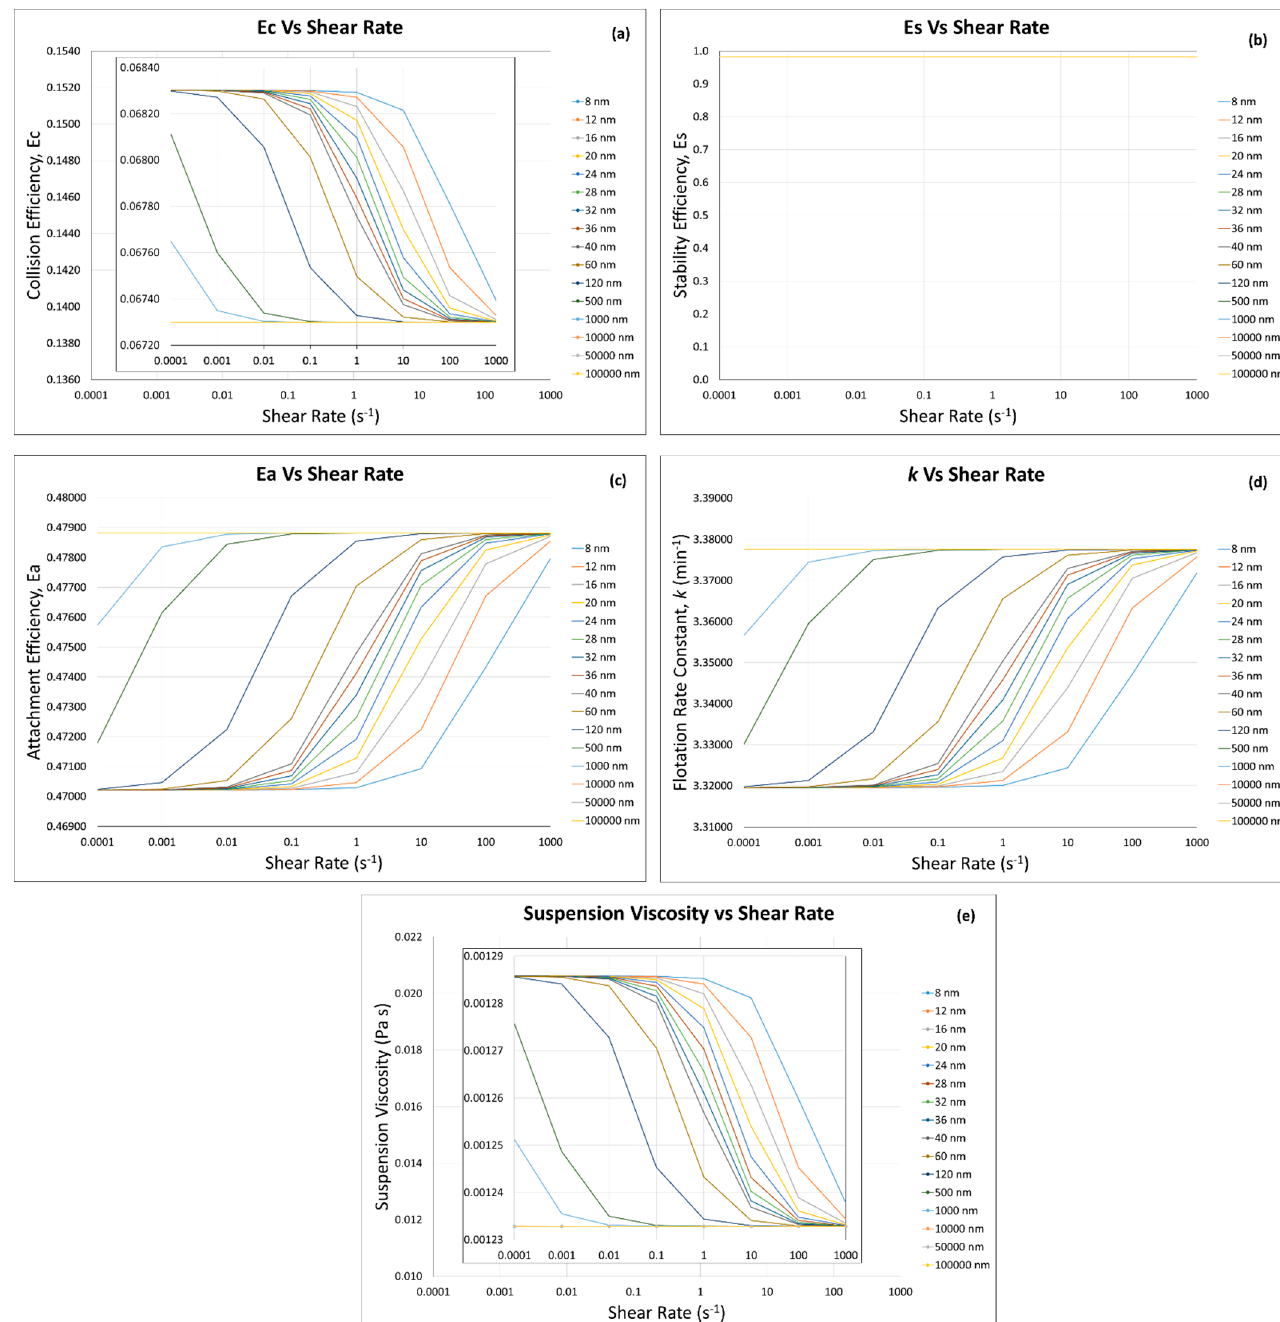
Figure 7. Flotation efficiencies: ( a ) collision, ( b ) stability, ( c ) attachment, and ( d ) rate constant by using the ( e ) respective suspension viscosity calculated by modified Krieger and Dougherty model at 𝜙 = 0.1 . Note: the major y-axes of subfigure ( a , e ) are made for the purpose of comparison.